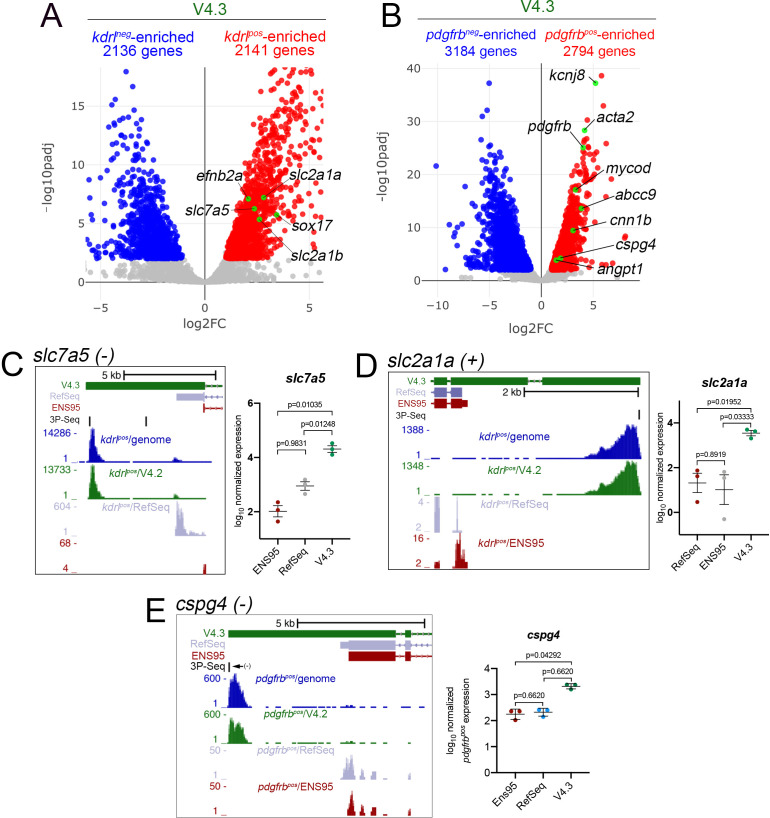
The V4.3 annotation improves the detection of cell-type-specific genes from bulk RNA-seq data.(A, B) Volcano plots of RNA-seq data from (A) kdrl-positive and negative and (B) pdgfrb-positive and negative cells quantified using V4.3. (A, B) Numbers of differentially expressed genes, along with selected known (A) endothelial or (B) mural cell genes are indicated with green dots. (A, B) Genes with significant differences (padj <0.05) are shown as red (log2 fold change pos/neg > 1) or blue (log2 fold changepos/neg <-1). (C–E) Left panels, UCSC browser images of (C) slc7a5 (minus strand), (D) slc2a1a (plus strand), and (E) cspg4 (minus strand) loci showing 3' UTR annotations from V4.3, ENS95, and RefSeq. Mapped depth of RNA-seq reads from indicated cell type on the genome, or assigned to each annotation are indicated, as are 3P-seq features. (C–E) Right panels, log10 normalized expression of (C) slc7a5, (D) slc2a1a, and (E) cspg4 in replicate RNA-seq samples (n = 3) quantified using indicated annotations. Values are normalized with median ratio normalization. (C, D) Values display normal distribution (Shapiro-Wilks test) and analysis of variance revealed statistical significance (slc2a1a, p=0.0160; slc7a5, p=0.0002). Adjusted p-values from Dunnett's multiple comparison tests are indicated. (E) Values are not normally distributed, variance determined by Friedman test (p=0.0278). p-values from Dunn's multiple comparison test are indicated. Error bars represent mean and standard deviation.